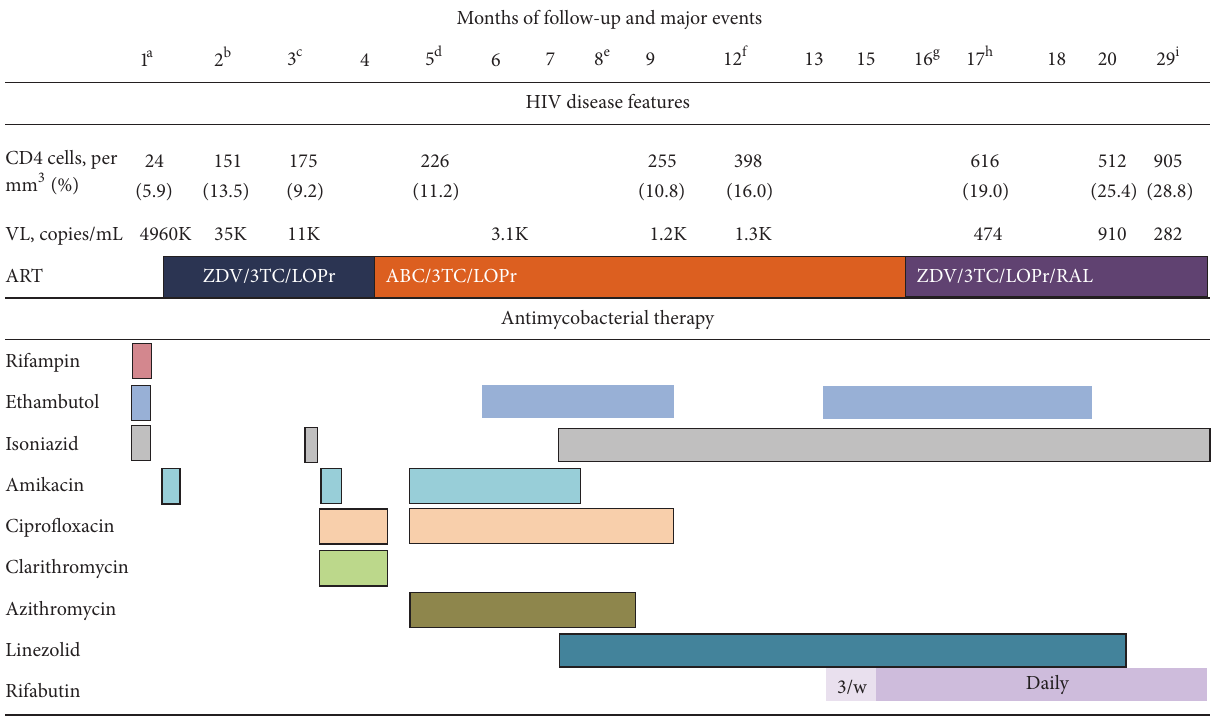
Figure 1: Major events, CD4 cell count and viral load measurements, antiretroviral therapy, and antimycobacterial therapy during the course of the disease. (a) Pneumocystis jiroveci pneumonia; culture of tracheal aspirate M. bovis positive; liver failure, antituberculosis therapy stopped; QuantiFERON TB test negative; ART started. (b) Hypoechogenic splenic lesions seen on ultrasound. (c) Necrotic lymph nodes seen on ultrasound; urticarial rash, after isoniazid reintroduction. (d) Disseminated skin lesions ( M. bovis cultured); QuantiFERON TB test positive; blood culture for M. bovis negative; cystic bone lesions. (e) Lopinavir/ritonavir replaced by nevirapine for 2 weeks. (f) Tibial bone biopsy culture for M. bovis positive. (g) Leg abscess culture for M. bovis positive. (h) Skin lesion and lymph node culture for M. bovis negative. (i) Antimycobacterial therapy stopped. VL, viral load (HIV-1 RNA); ART, antiretroviral therapy; ZDV, zidovudine; 3TC, lamivudine; LOPr, lopinavir/ritonavir; ABC, abacavir; RAL, raltegravir; 3/w, three times weekly; TB, tuberculosis.